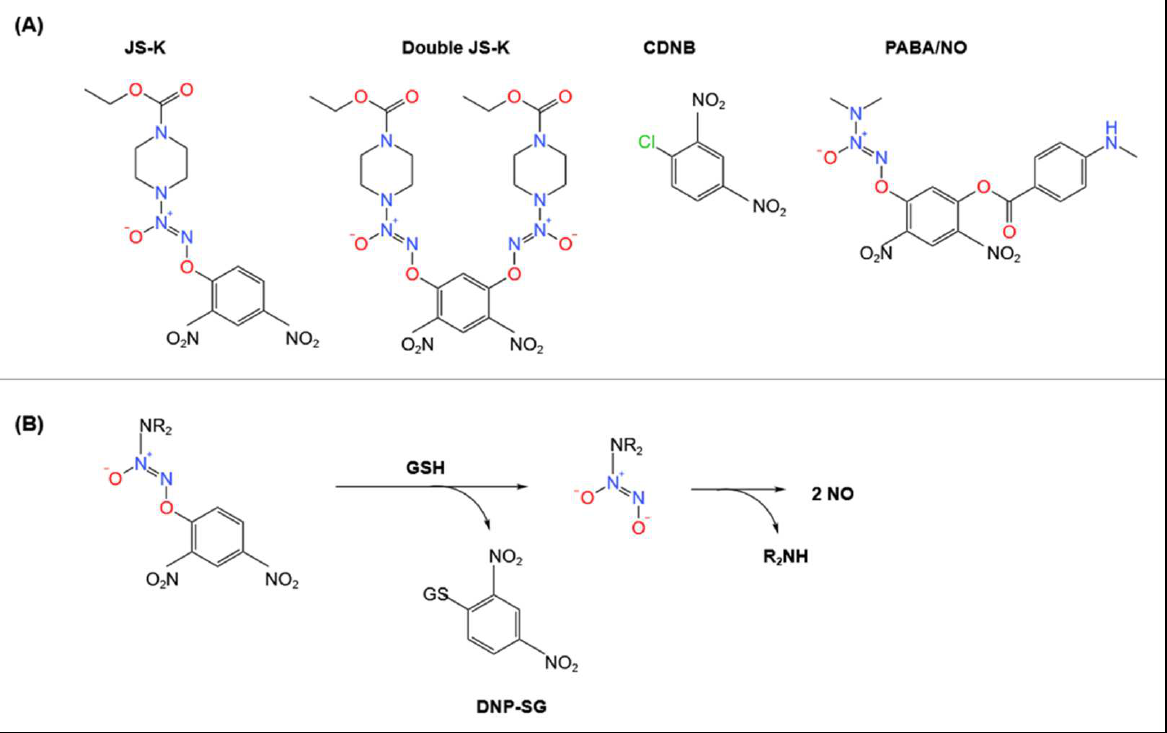
Figure 4. Pro-drugs metabolized by GSTs. ( A ) Line drawings of the chemical structures of common pro-NO drugs metabolized by GSTs. ( B ) Schematic describing the general mechanism of pro-NO drug biotransformation by GSTs.